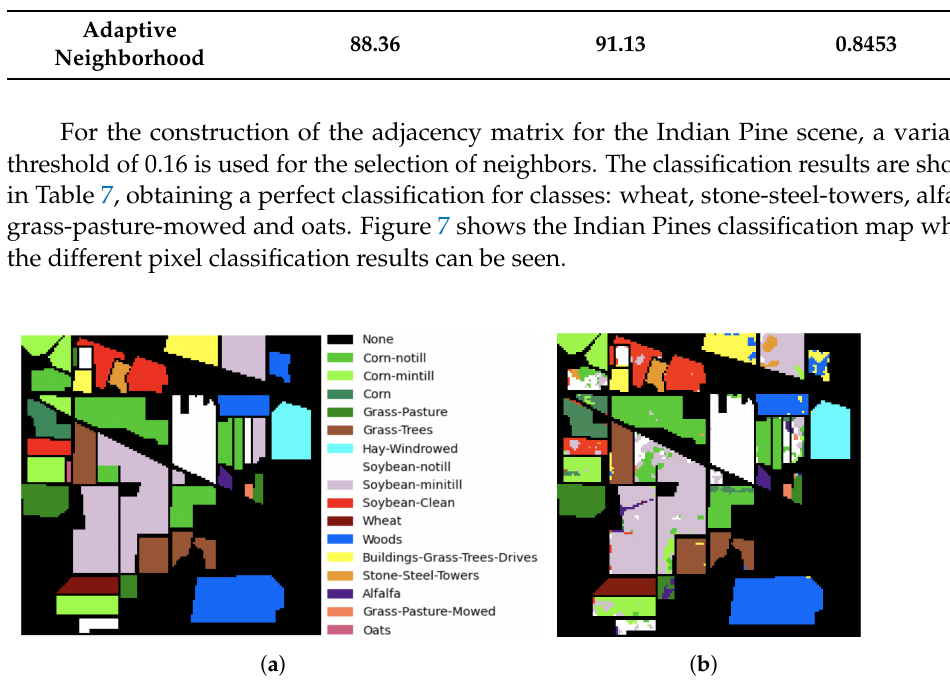
Figure 7. Classification map in Indian Pine dataset. ( a ) Groundtruth map. ( b ) AN-GCN. Table 7. Classification performance (%) of various GCN methods for Indian Pines